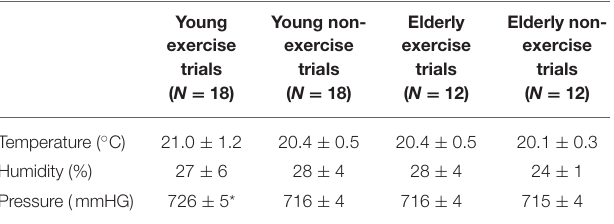
TABLE 1 | Room environmental conditions (mean ± SD) during the exercise and non-exercise